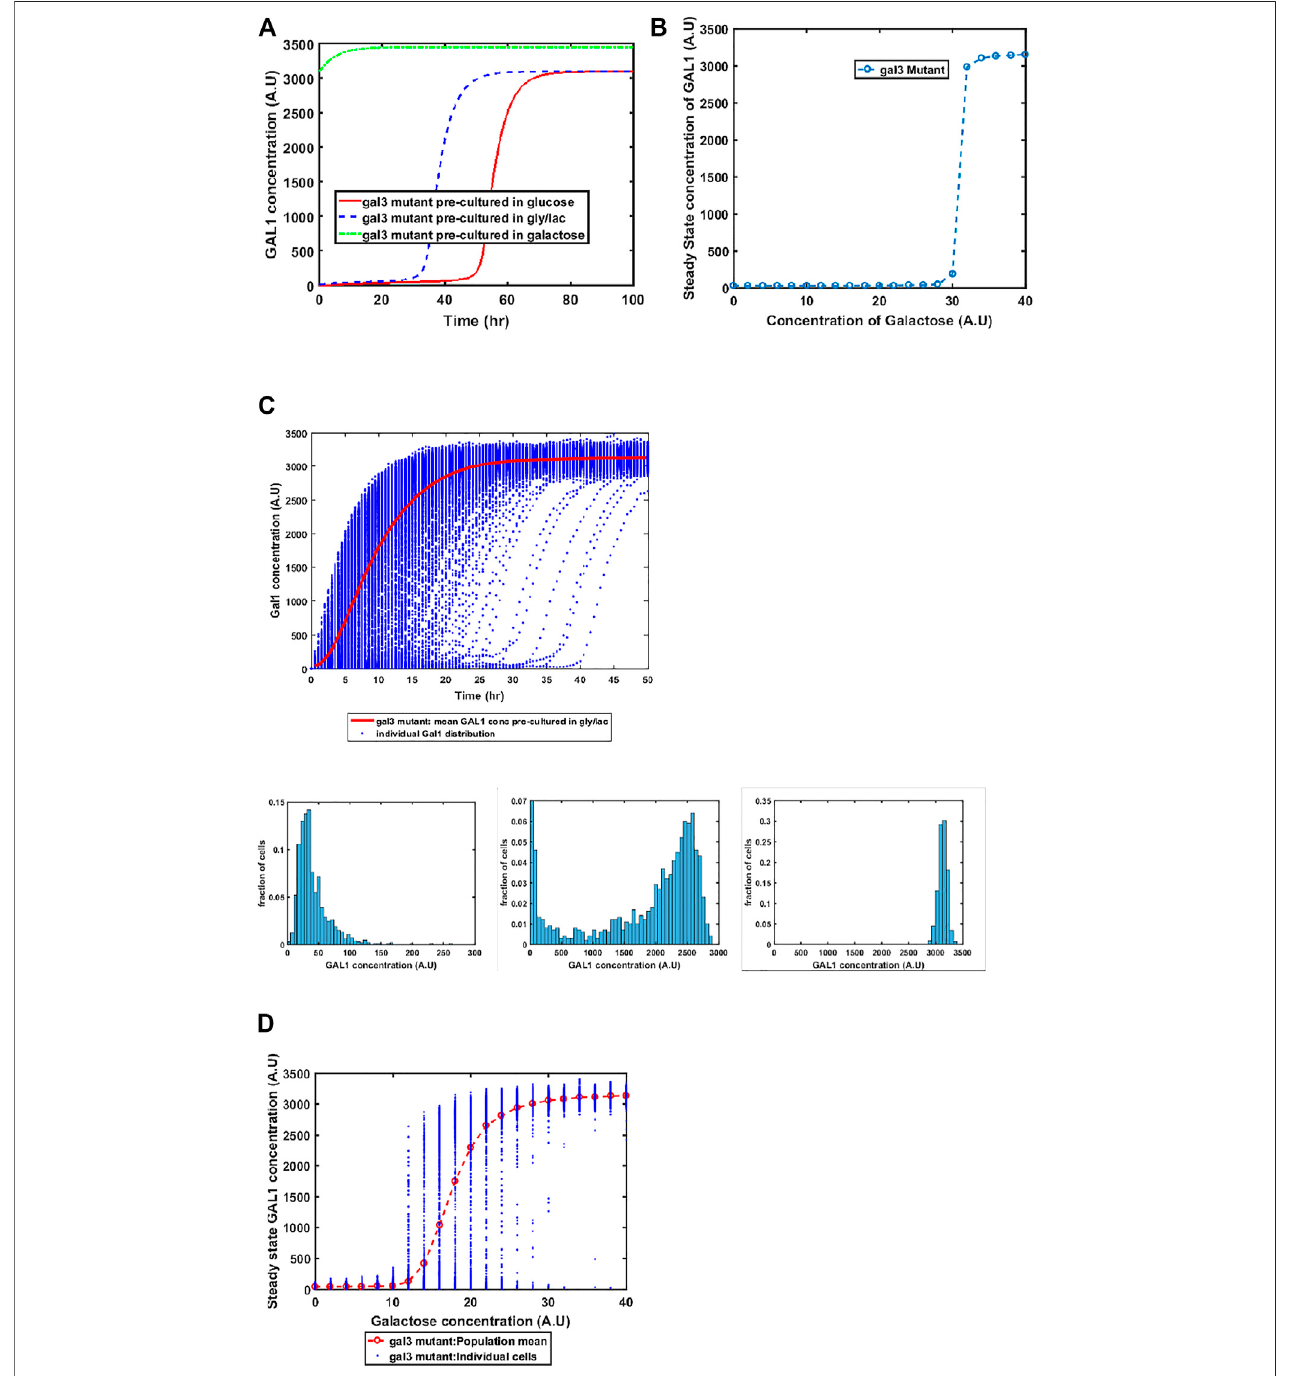
FIGURE 5 | Dynamics of gene expression for gal3 Δ strain. (A) Activation of GAL network in galactose [concentration, 30 (A.U)]. GAL1 pro fi le when cells are pre- culturedingly/lac(dashedblueline),glucose(solidredline),andgalactose(dashedgreenline). (B) SteadystateconcentrationofGAL1proteinatdifferentconcentrations of galactose. Note that the system exhibits a behaviour which is qualitatively different than the wild type behavior. The threshold of galactose concentration is no longer present. (C) DynamicGAL1responseatgalactoseconcentrationof30(A.U)for1000cellspre-growningly/lac.HistogramsofGAL1expressionat30 min,5 h,and 50 h. (D) Steady state concentration of GAL1 under different concentration of galactose.